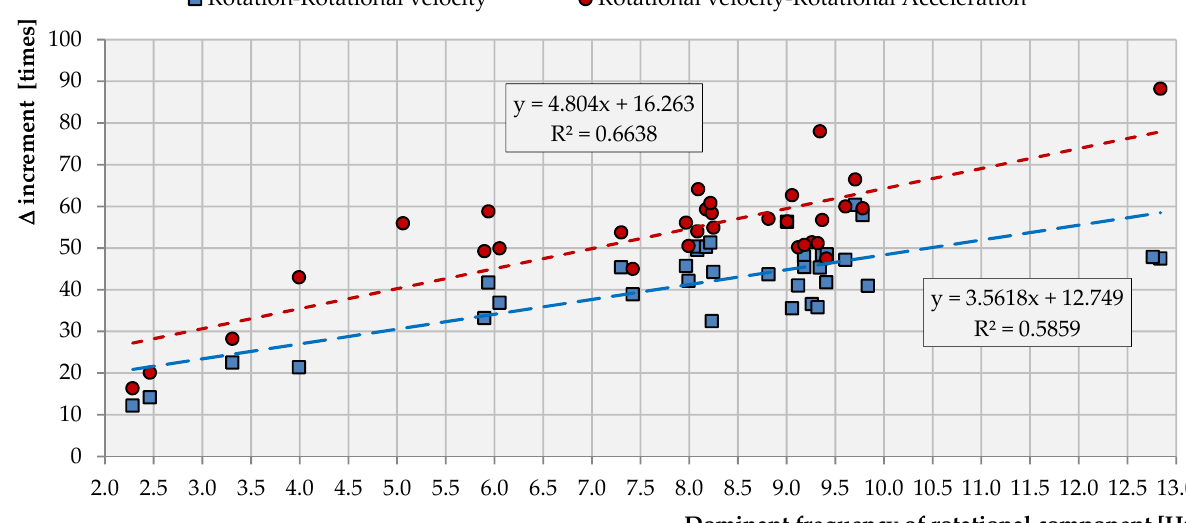
Figure 12. The relation between rotation, rotational velocity and rotational acceleration.